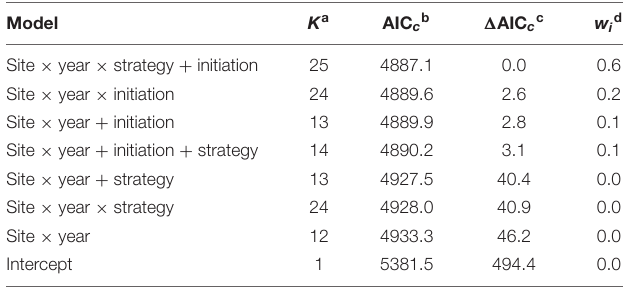
TABLE 5 | Top-ranked models (plus intercept-only model) explaining daily survival rates of shorebird nests at Utqia˙gvik, Colville River, and Prudhoe Bay, 2015–2018. Model K a AIC c b